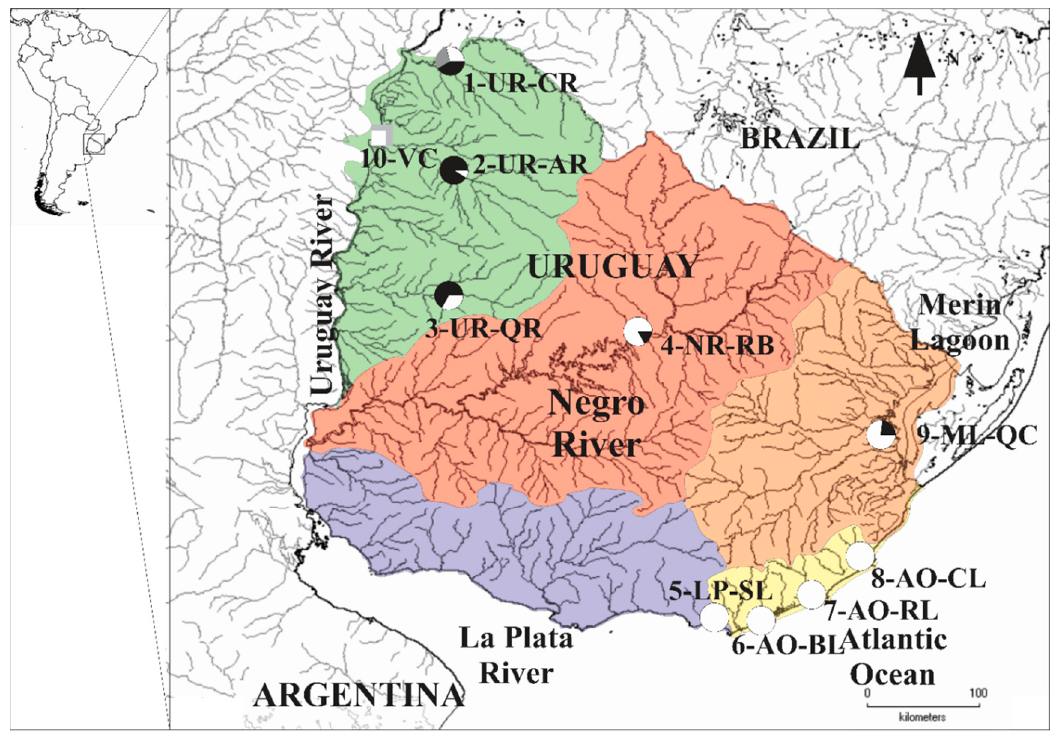
Figure 1. Rhamdia quelen samples analyzed from the La Plata Basin (LP), the Patos-Merin Basin system (PM) and the coastal lagoons draining to SW Atlantic Ocean (AO) (LP-PM-AO) in South America. Localities are included in di ff erent geographical basins, namely, the Uruguay River basin (UR: green): Cuareim River (1-UR-CR), Arapey River (2-UR-AR) and Queguay River (3-UR-QR); the Negro River basin (NR: red): Rinc ó n del Bonete dam (4-NR-RB), Tacuaremb ó ; the La Plata River basin (LP: purple): Sauce Lagoon (5-LP-SL); the SW Atlantic Ocean coastal basin (AO: yellow): Blanca Lagoon (6-AO-BL), Rocha Lagoon (7-AO-RL) and Castillos Lagoon (8-AO-CL); the Merin Lagoon basin (ML: orange): Quebrada de los Cuervos (9-ML-QC). Additionally, individuals from Villa Constituci ó n hatchery (10-VC) were analyzed. Pie charts for each population display the mitochondrial lineage frequency of each population (Rq2: grey; Rq4: black and Rq6: white) based on R í os et al.